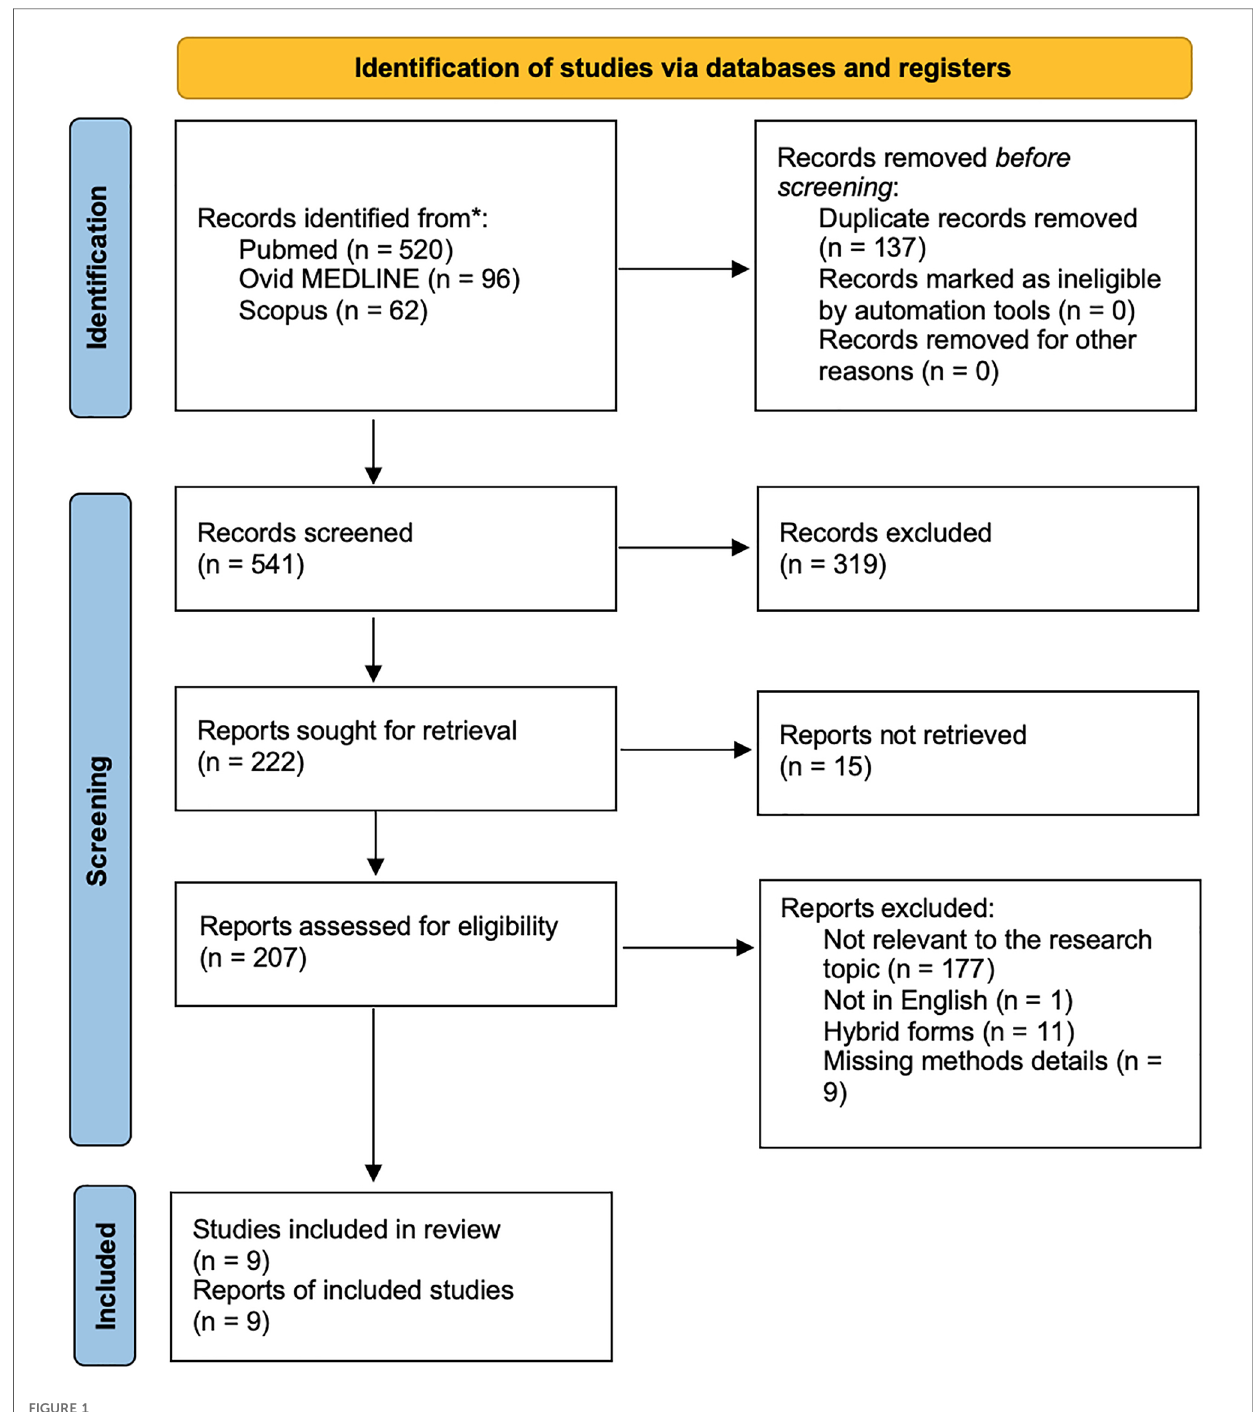
FIGURE 1 PRISMA diagram showing the research strategy and selection of papers